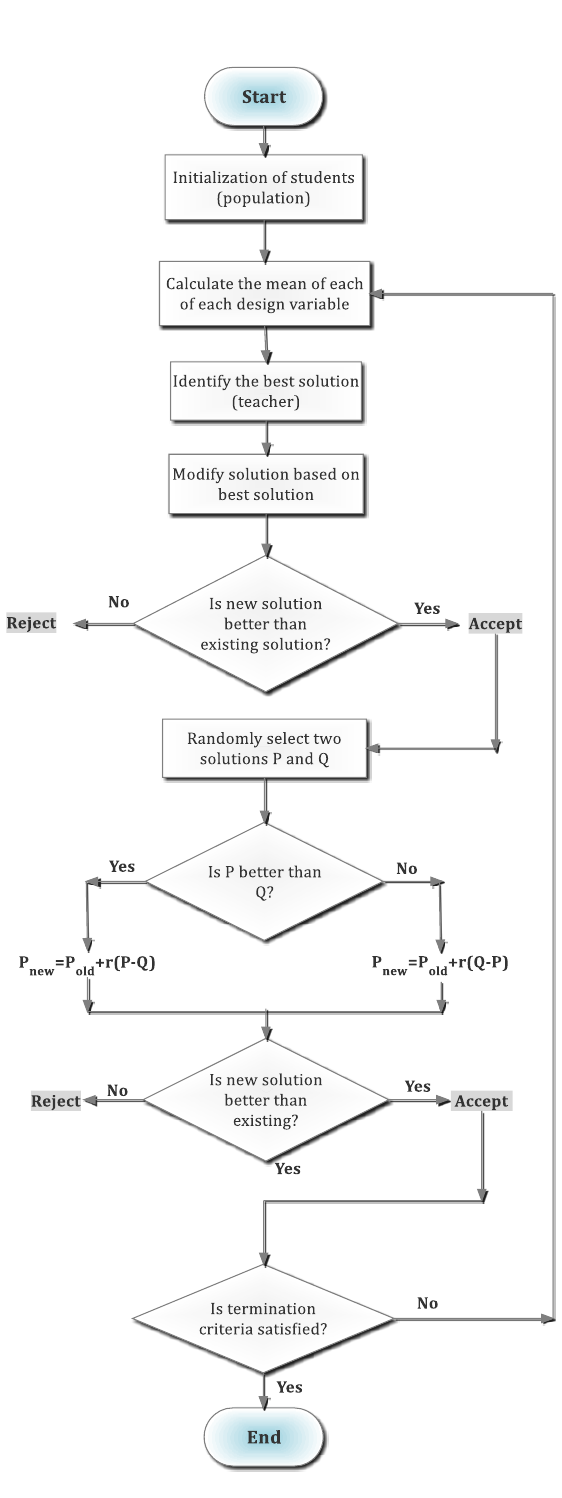
Figure 1. Flowchart for teaching — learning-based optimization (TLBO).